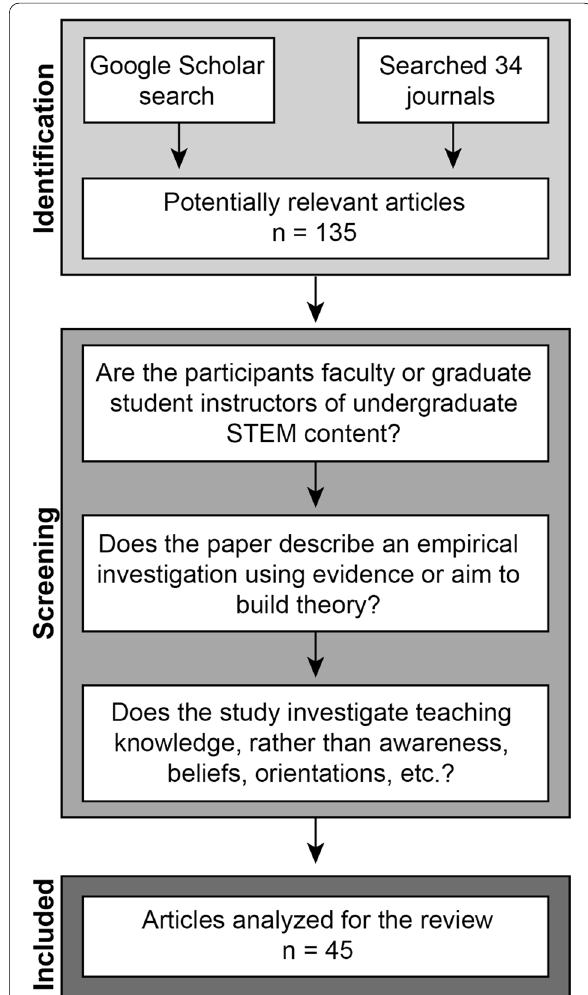
Fig. 1 Flow diagram of how we identified and screened articles to arrive at the final set of articles for